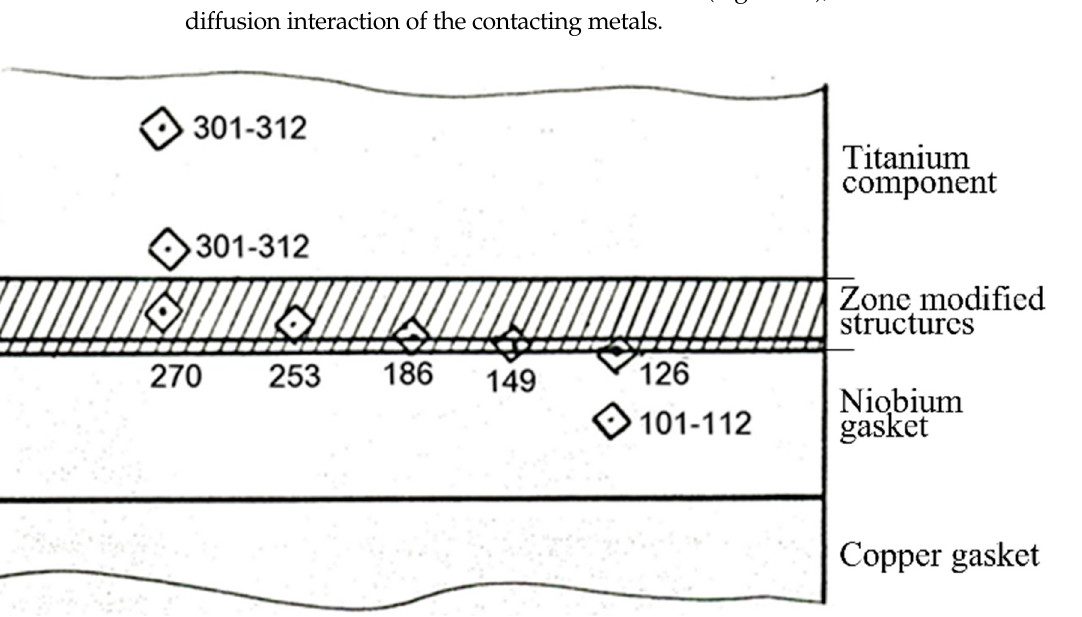
Figure 16. Distribution of microhardness in the 12KH18N10T+M1+NbStrip-1+VT-14 joint zone.